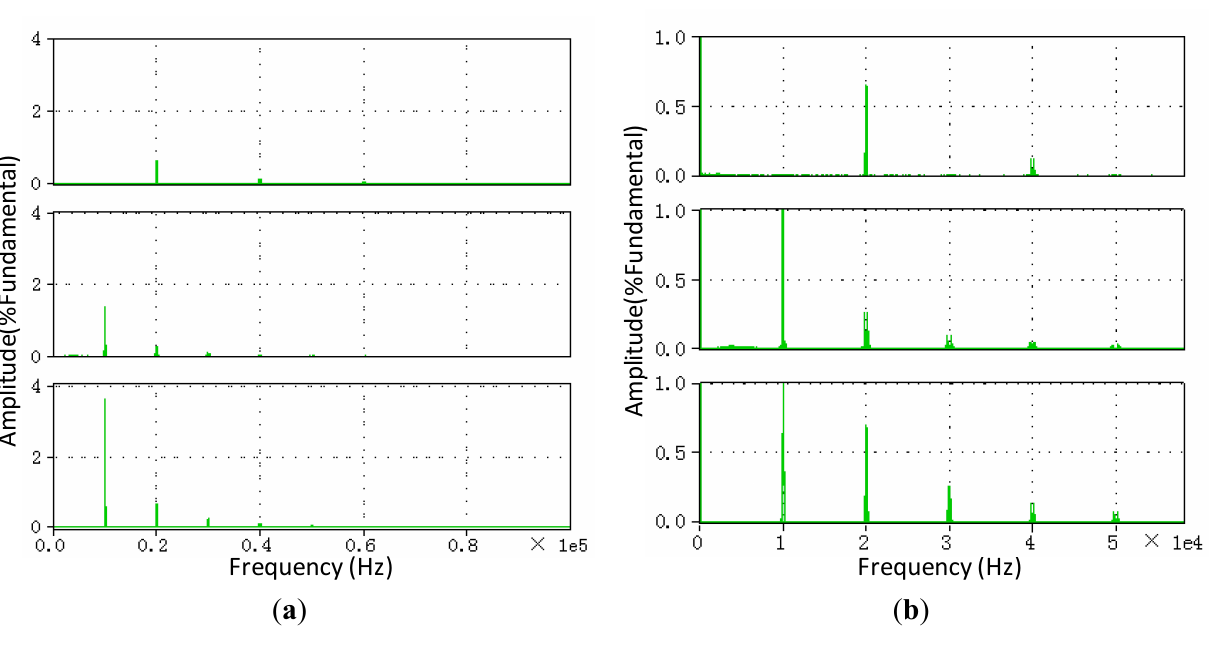
Figure 14. Grid-side current spectrum waveforms of BSS-FBC, single-phase PWM converter with unipolar and bipolar control: ( a ) Normal view; ( b ) Partial view.